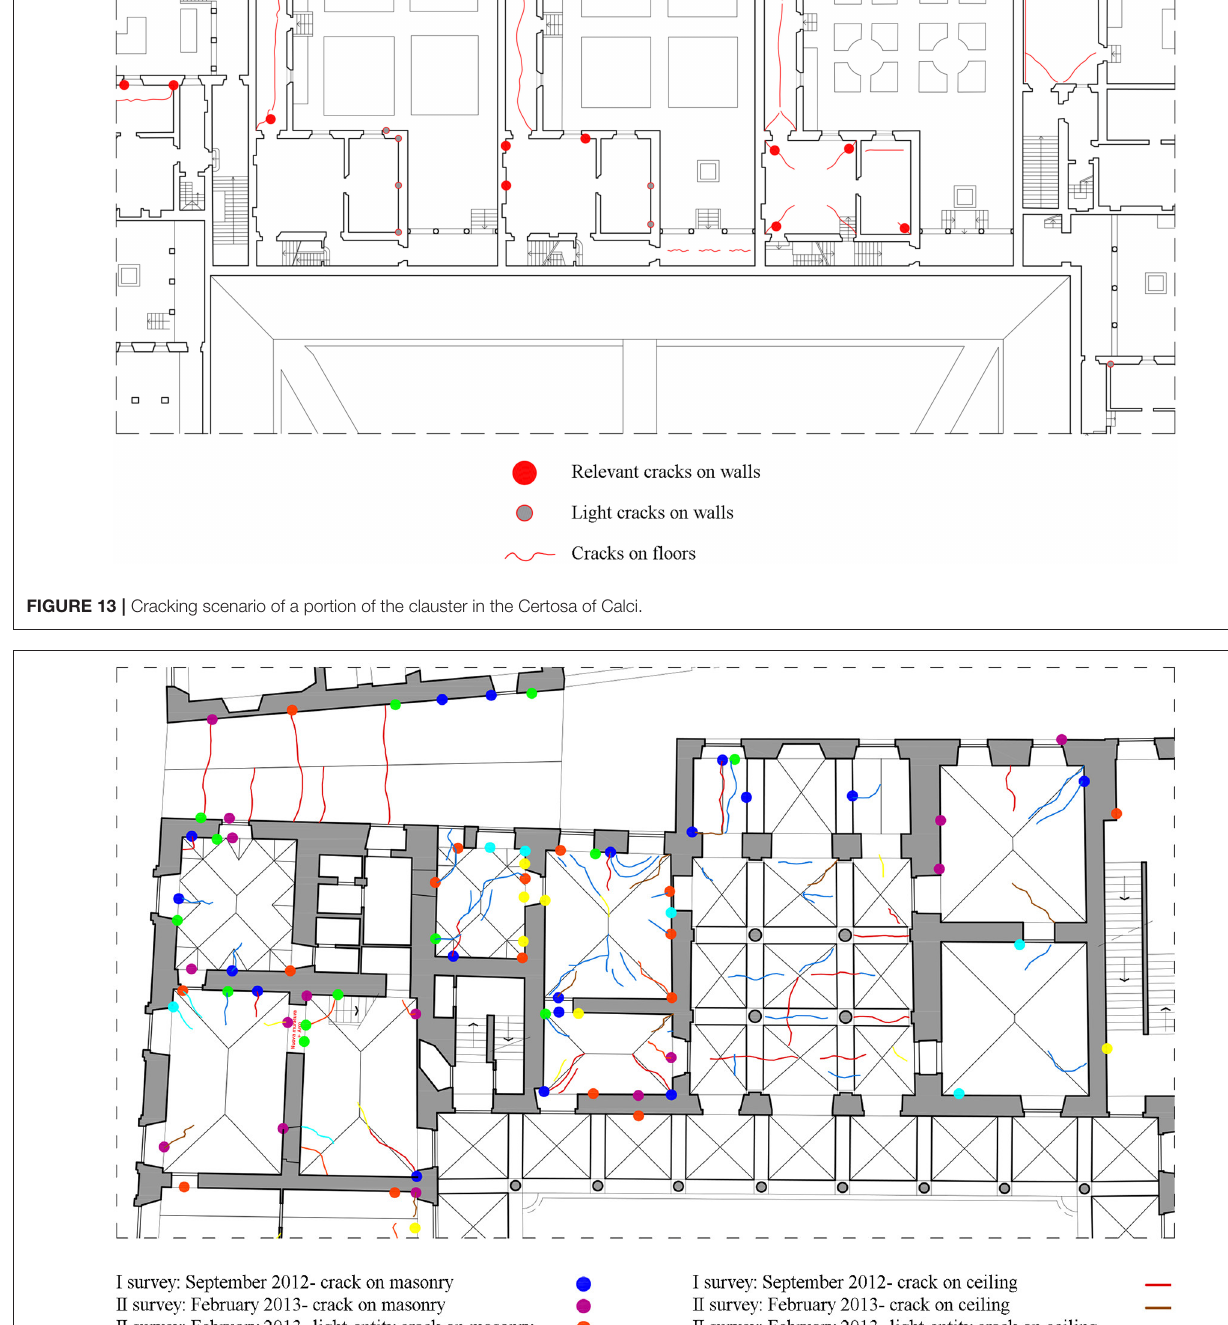
Frontiers in Built Environment |